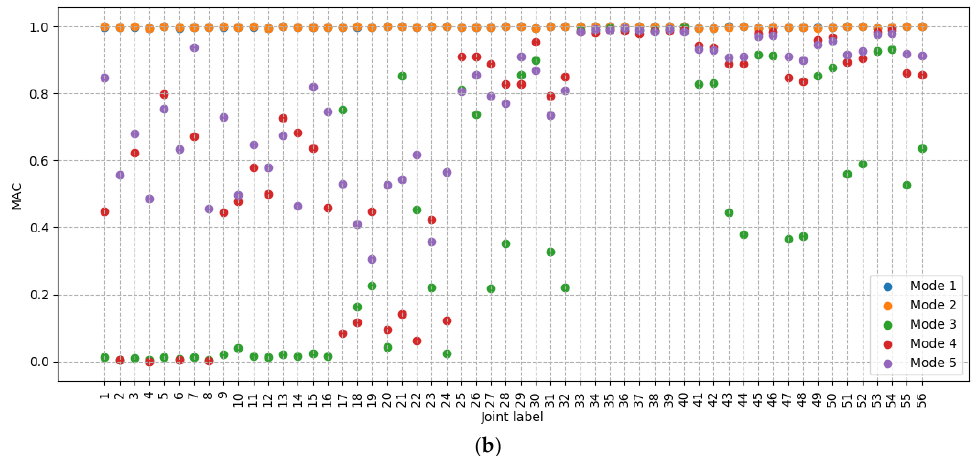
Figure 10. Change in mode frequency ( a ) and MAC value ( b ), calculated relative to undamaged case.